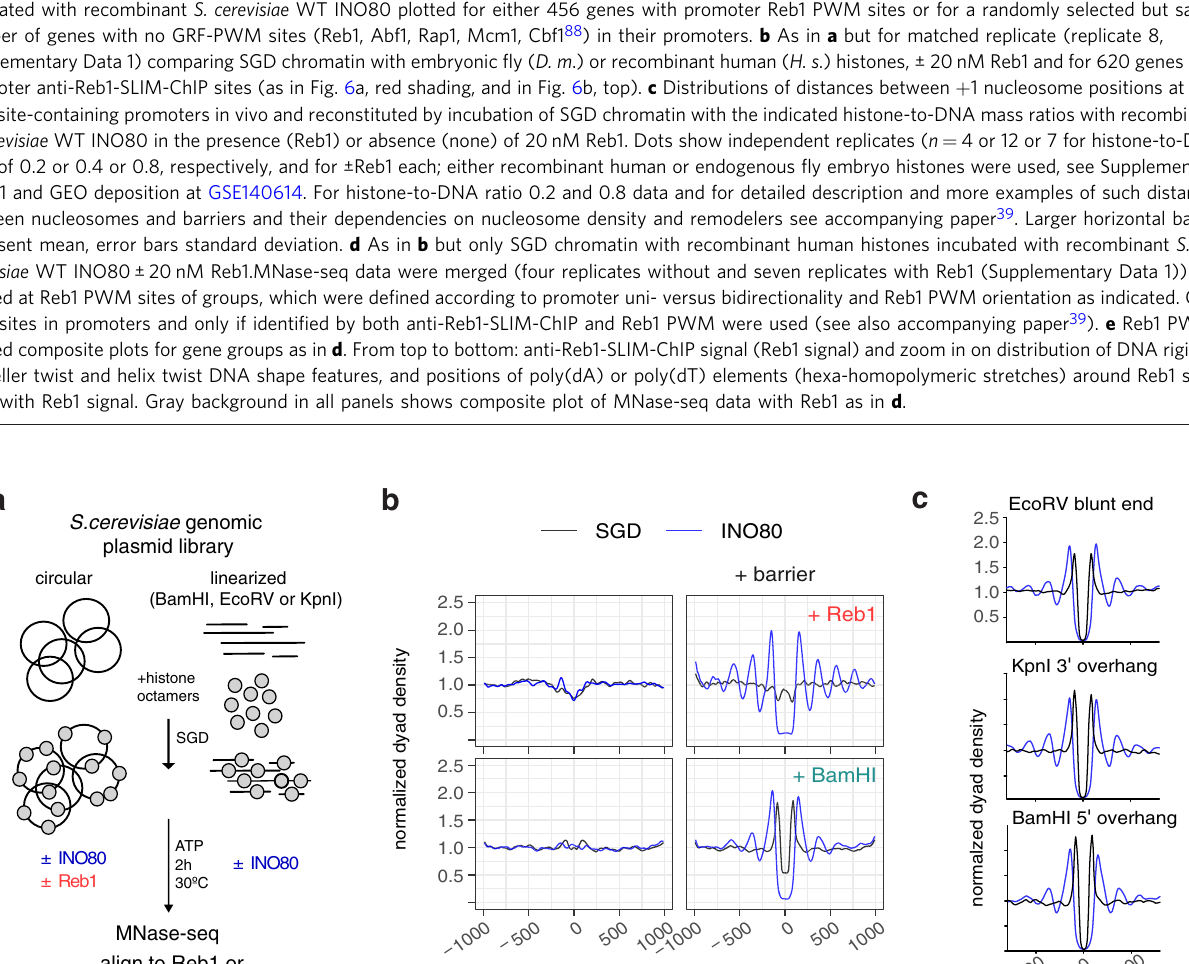
Fig. 8 DNA ends are potent barriers for nucleosome positioning by INO80. a Overview (analogous to Fig. 2a) of reconstitution with circular versus RE- precleaved plasmid libraries. b Composite plots (merged replicates, n = 2) of MNase-seq data aligned at barrier sites, i.e., anti-Reb1-SLIM-ChIP-de fi ned Reb1 sites or BamHI sites for: top, SGD prepared with circular plasmid library and incubated without (SGD) or with recombinant S. cerevisiae WT INO80 (INO80) and with ( + Reb1) or without 20 nM Reb1 as indicated, and bottom: as top but with BamHI-precleaved library if indicated ( + BamHI). c As b , but for SGD chromatin with plasmid libraries precleaved with the indicated RE and data aligned at the indicated RE cut sites and only one replicate each (Supplementary Data 1). Strong peaks fl anking cut RE sites in SGD chromatin without INO80 remodeling re fl ected an MNase-seq bias, i.e., due to the pre- cleavage, the probability is increased that MNase releases a mononucleosomal fragment with the cut site as one end relative to releasing fragments from other genomic